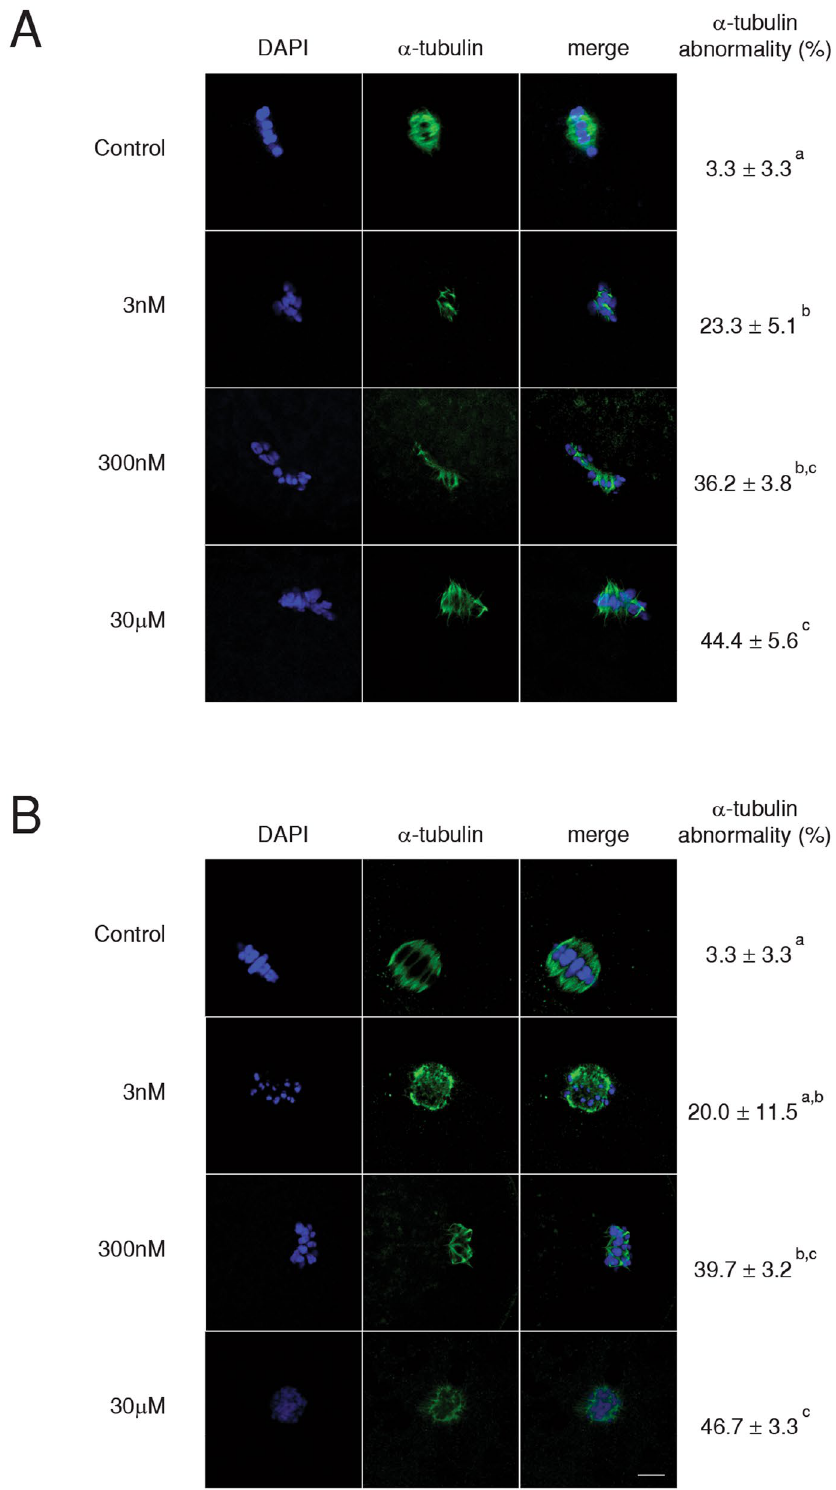
Figure 2. Effects of BPS on meiotic spindle formation during the maturation of porcine oocytes. Representative pictures showing defects in the morphology of spindle organization and chromosome alignment in oocytes after 24 h ( A ) or 48 h ( B ) of culture in vitro after BPS (3 nM, 300 nM, and 30 μ M) treatment. Green colour indicates α -tubulin, blue indicates DAPI. Scale bar = 10 µ m. Percentage of α -tubulin abnormalities after 24 h (n = 83) and 48 h (n = 82) of culture in vitro are presented to the right side of the images. The data are expressed as the mean ± SEM of three independent experiments. Different superscript letters denote statistical significance (P <